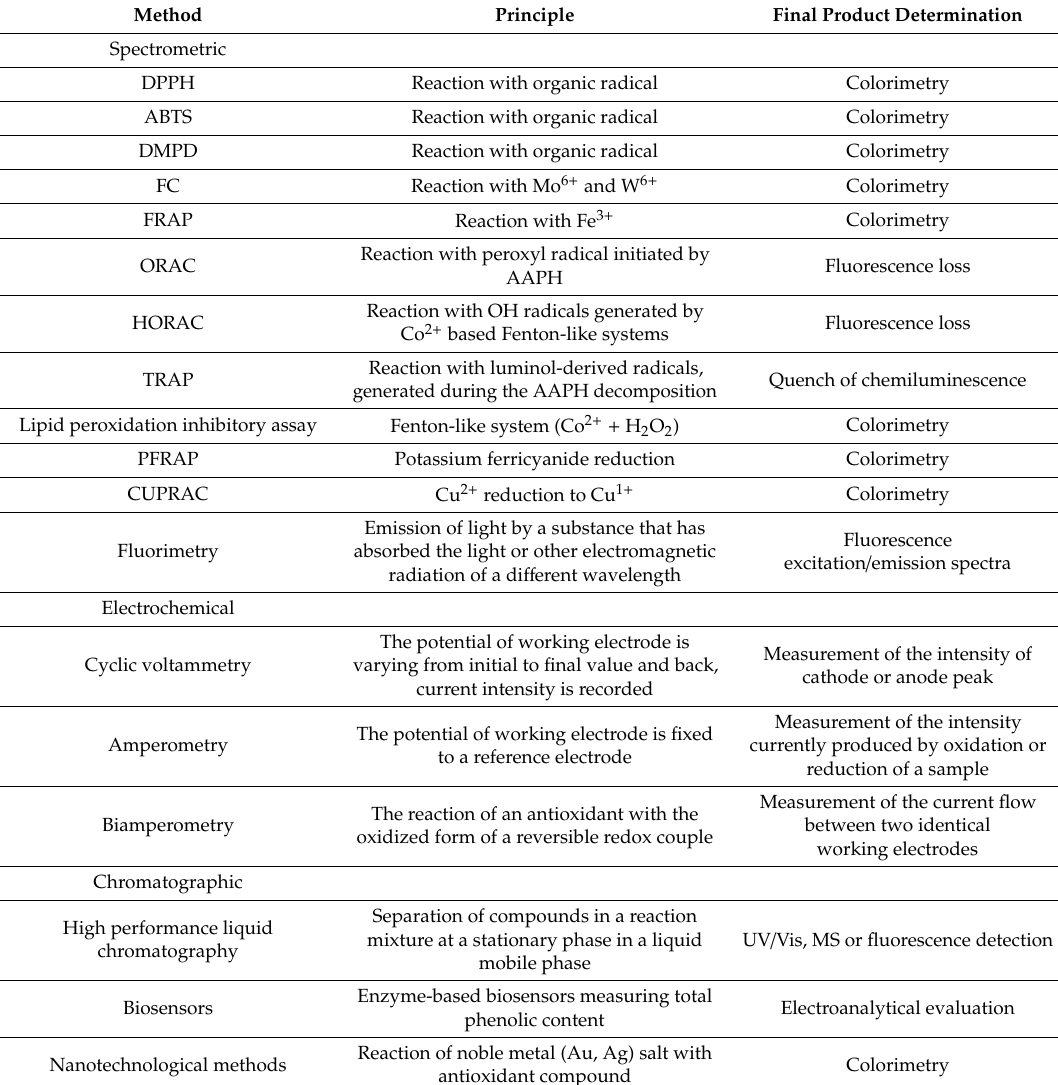
Table 1. Methods for antioxidant capacity